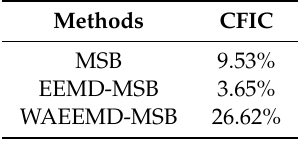
Figure 14. Diagnosis results for the bearing outer race fault using: ( a ) WAEEMD-MSB; ( b ) conventional MSB; ( c ) EEMD-MSB. Table 3. The CFIC of conventional MSB, EEMD-MSB, and